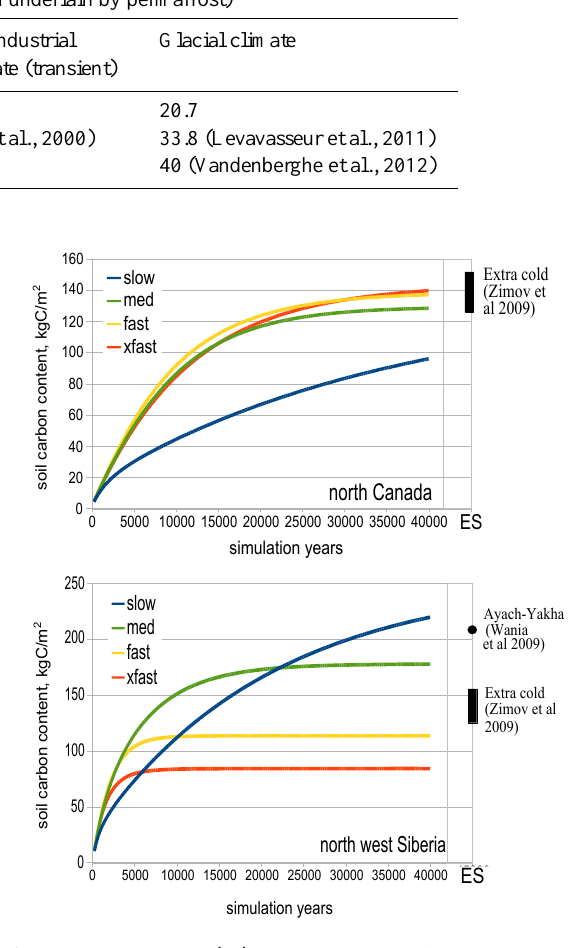
Figure 14. Modelled permafrost area for (a) : PI(tr) simulation, (b) LGM(eq) simulation for LOW-MEDIUM permafrost area. Over- laid in orange are data estimates from Circumpolar Atlas (Jones et al., 2009) for the present day, Vandenberghe et al. (2008) for LGM Eurasia, French and Millar (2013) for LGM N. America.